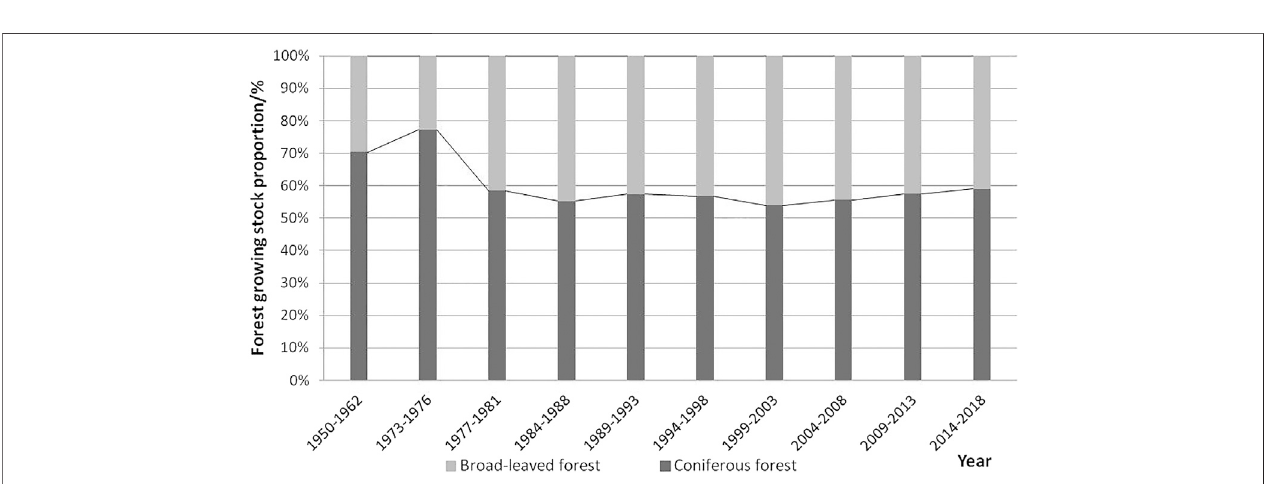
Frontiers in Environmental Science |